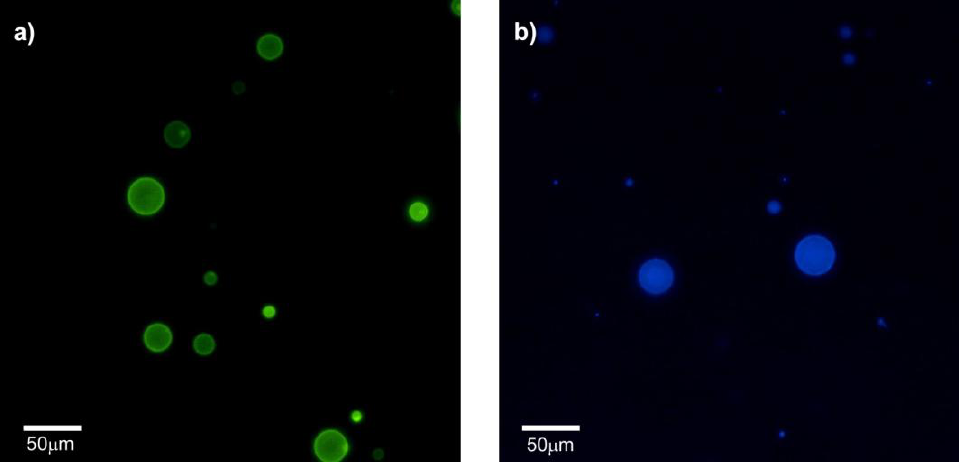
Figure 10. Fluorescence microscopy images of a mixture of GUVs of DOPC-BODIPY and DOPC/DOPG (3:1) observed after HTMA-PFP addition, upon excitation with ( a ) Vis-light and ( b ) UV-light (both images correspond to the same